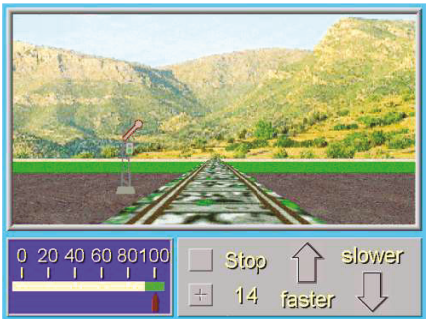
Figure 5: Example of the divided attention task on level 14 of the RehaCom module.